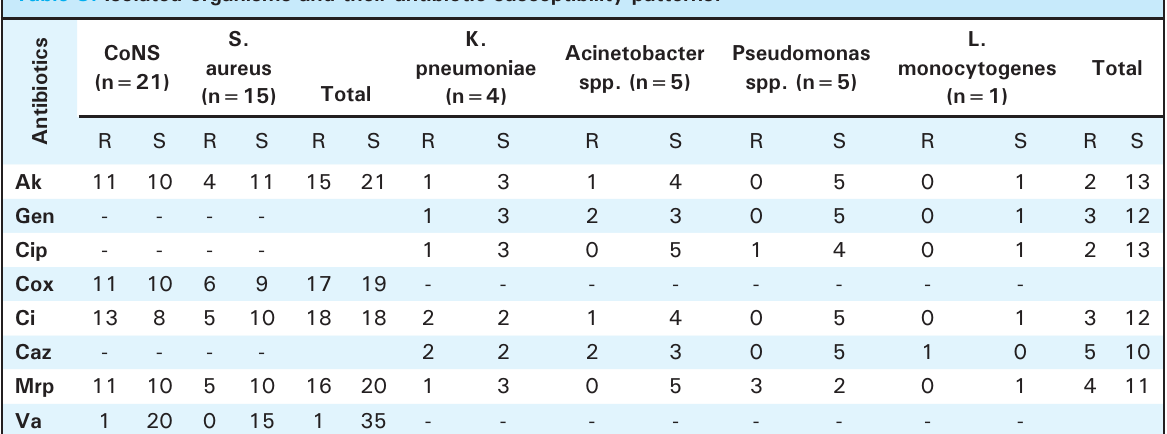
Table 3. Isolated organisms and their antibiotic susceptibility